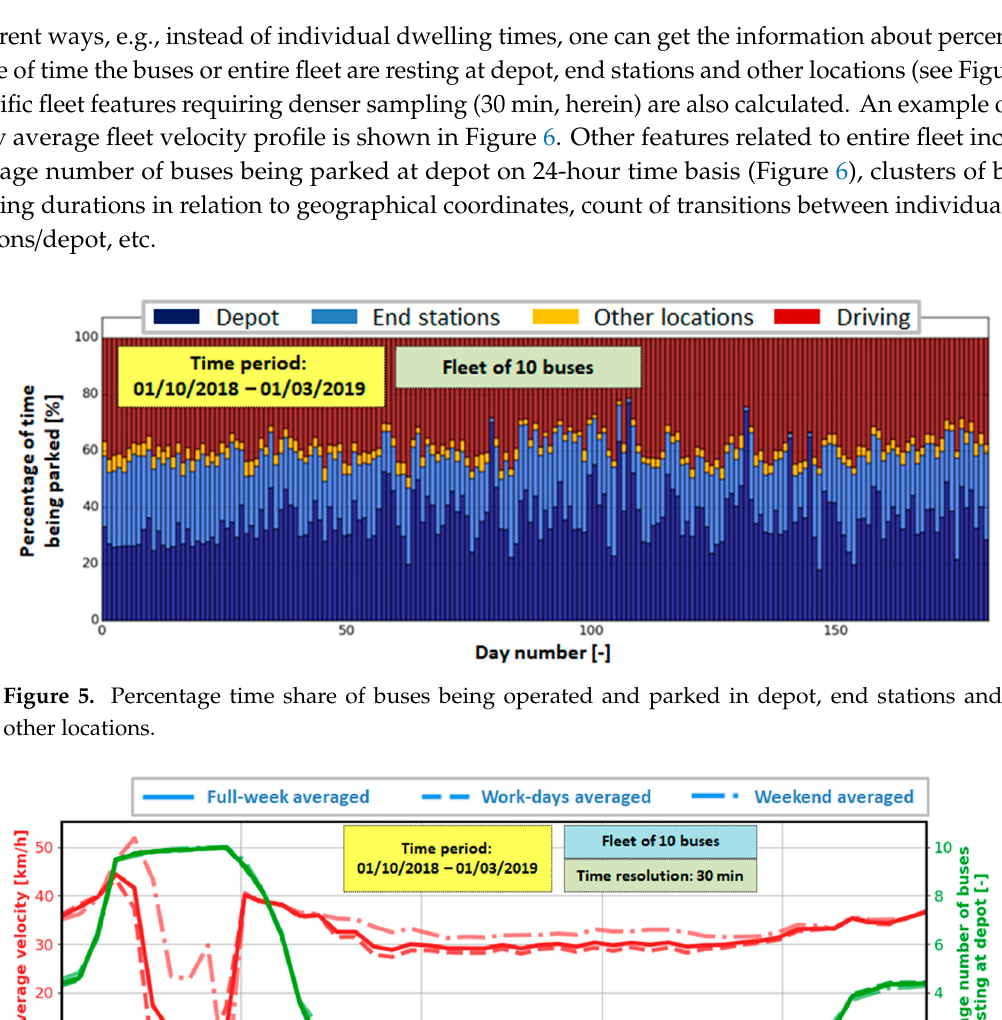
Figure 6. Time profiles of fleet average velocity and average number of buses resting at the depot, both given on daily basis and averaged over the considered five-month period.